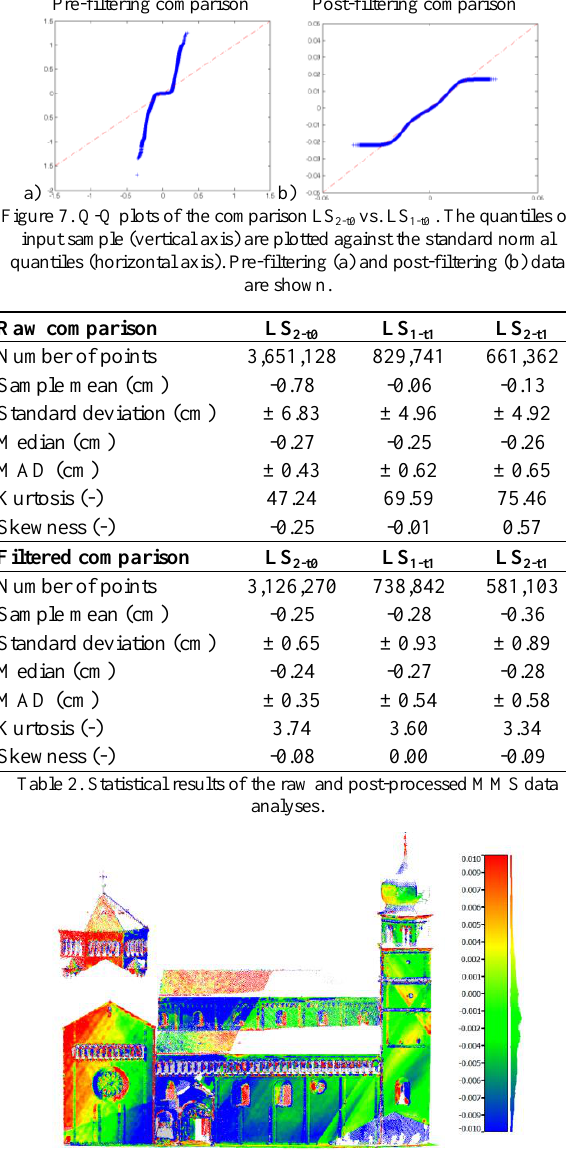
Figure 8. Colour-coded map of the comparison between LS 2-t0 vs. LS 1-t0 . Differences range between – 0.01 m (blue) and 0.01 m (red). White areas represent no-data